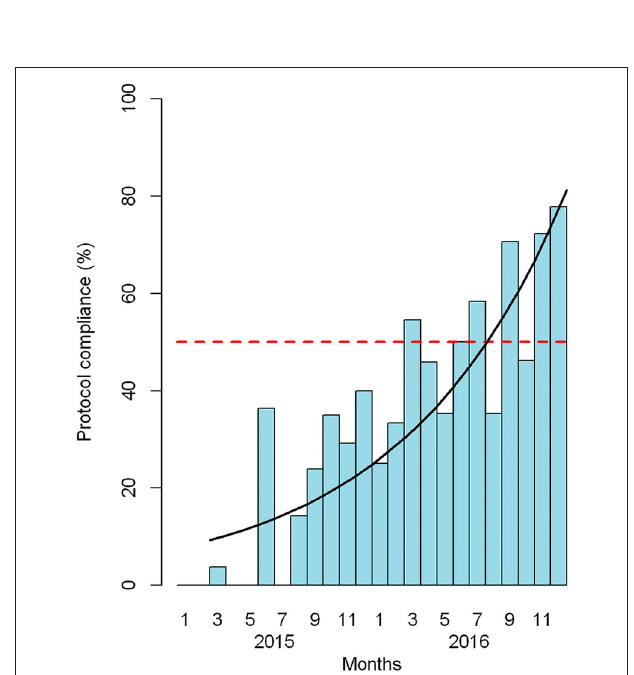
FIGURE 3 | Adherence to the sepsis package among eligible patients by month. Red dashed line: 50% adherence. Black line: estimated growth of